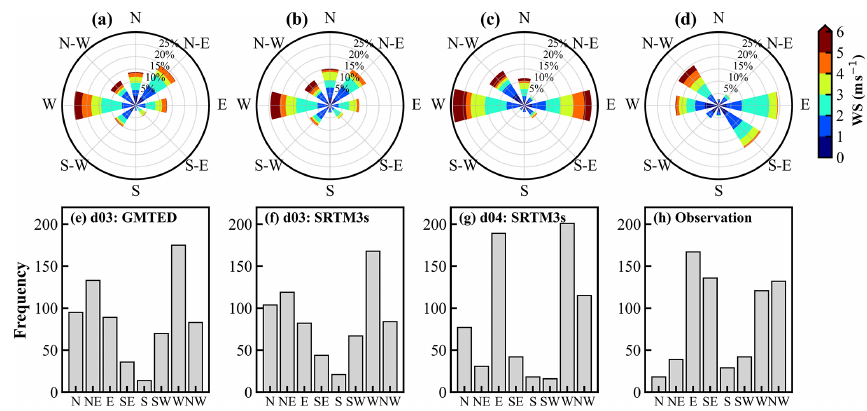
Figure 12. Wind roses for (a) d03 using GMTED, (b–c) d03 and d04 using SRTM3s topography data, and (d) surface observations. The corresponding frequency distributions of the wind directions are shown in (e–f) . The comparison of the wind speed and direction is shown for the month of September in